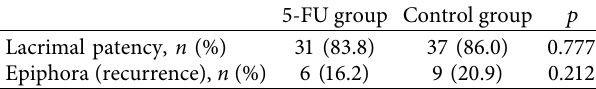
Table 2: Lacrimal patency and recurrence rates of the